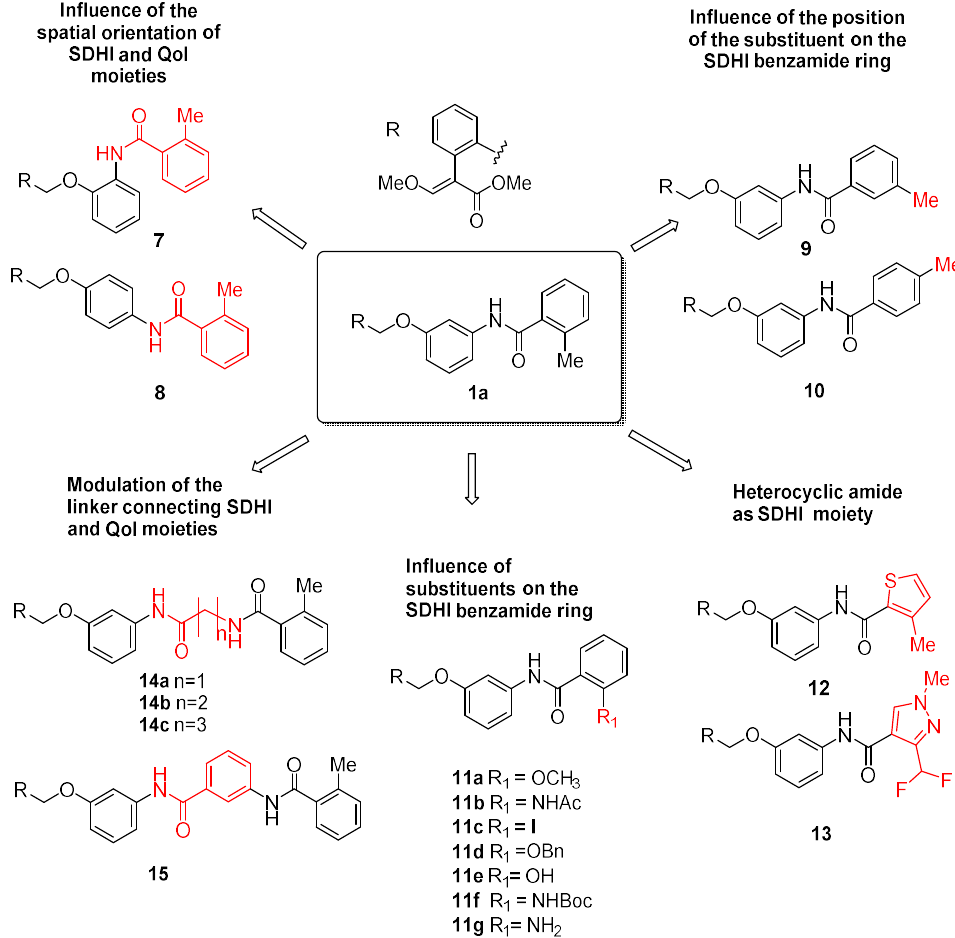
Figure 2. Design strategy to optimize the structure of compound 1a to obtain new dual SDHI-QoI ( 7 - 15 ).